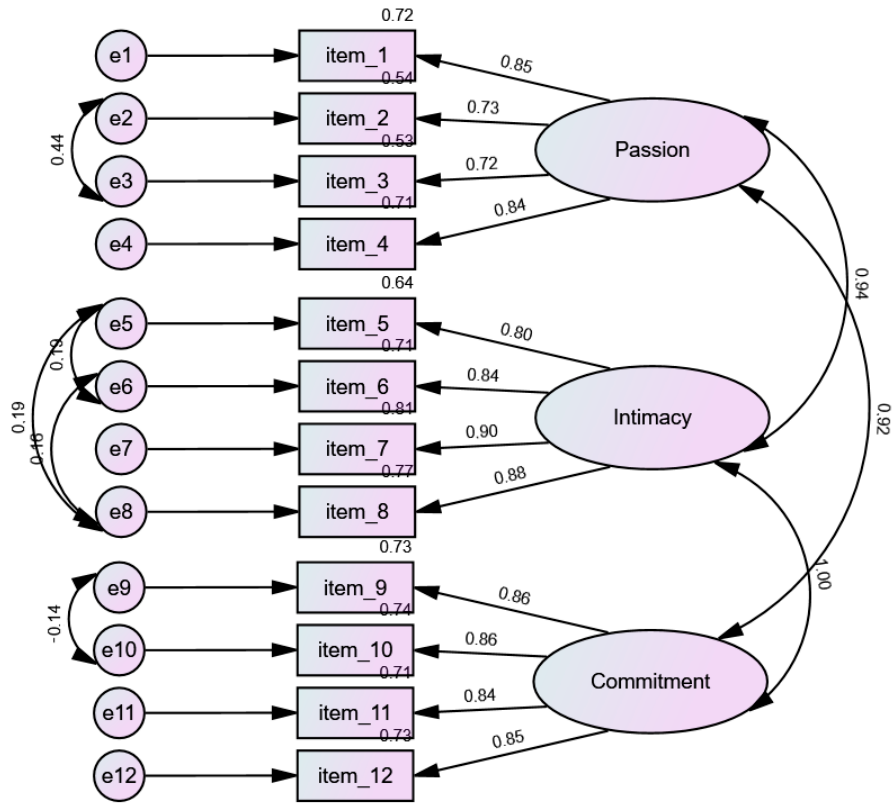
Figure 1. Theory driven SLS-12 model ( n = 470).